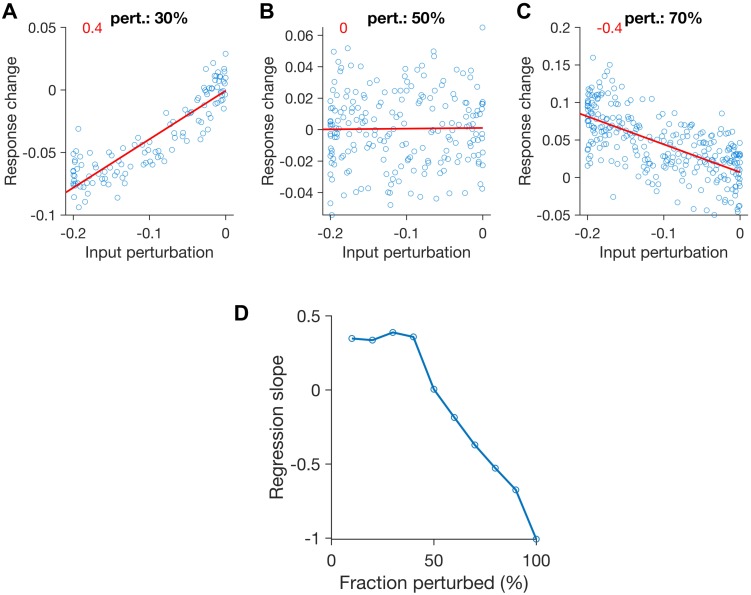
Feature-specific paradoxical effects in networks with partial perturbation of inhibition.(A–C) Response change as a function of input perturbations for perturbed inhibitory neurons under patterned perturbations (similar to Figure 2C). Different fraction of inhibitory neurons are perturbed in (A): 30%, (B): 50% and (C): 70%. Other parameters and conventions are otherwise the same as Figure 2. (D) The slope of regression line fitted to the data (red lines in (A-C), with the slope denoted with the numbers in red) for different fractions of patterned perturbation. More than 50% of the inhibitory population should be perturbed to observe the specific paradoxical effect (assayed by the negative slope of the regression).